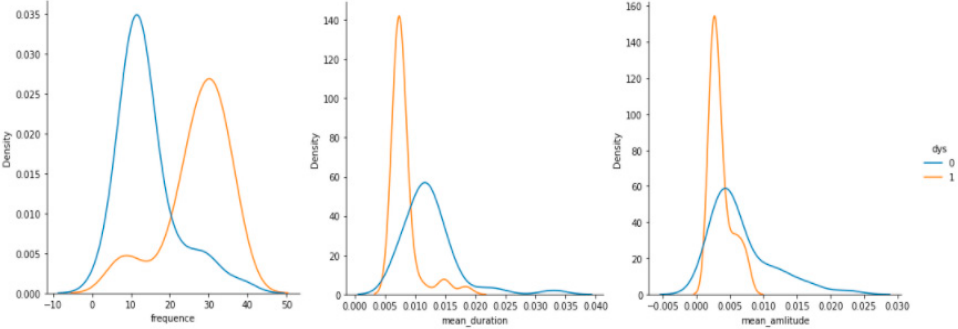
Figure A10. Distribution of the DGI for the painting 6 dataset.